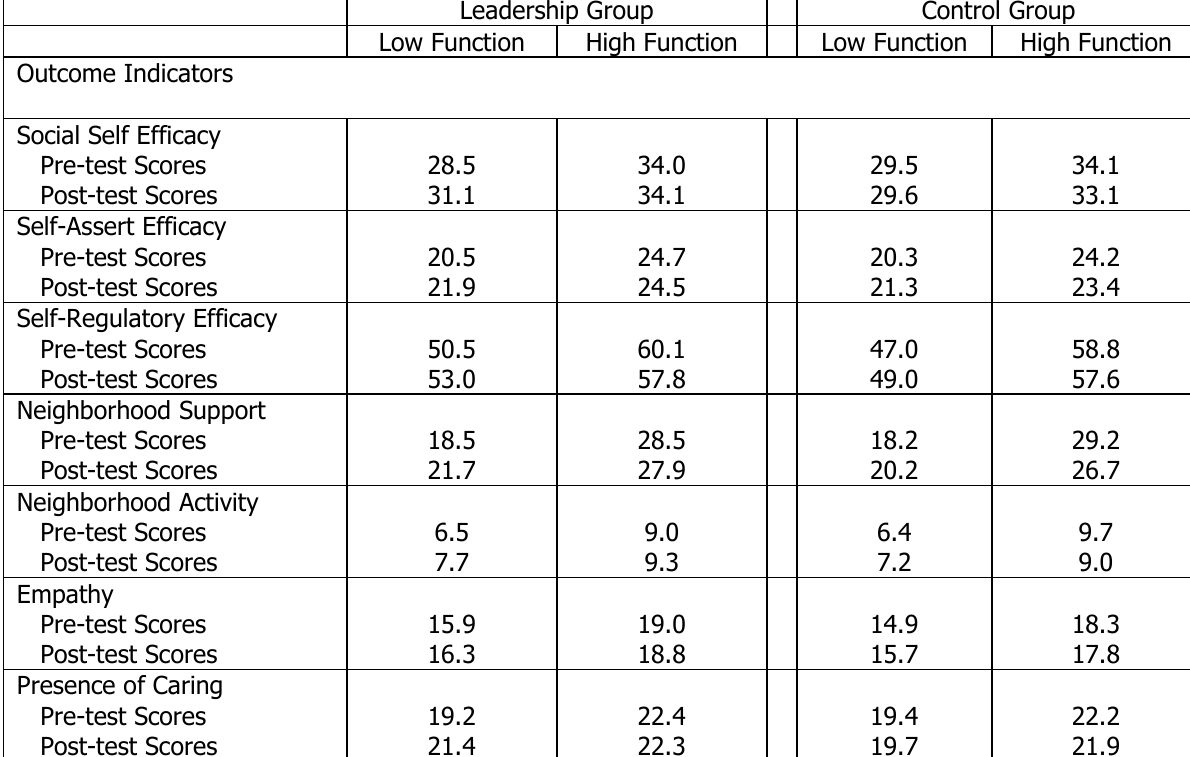
Mean scores on pre-test and post-test outcome measures for high and low functioning youth in leadership and comparison groups. Leadership Group Control